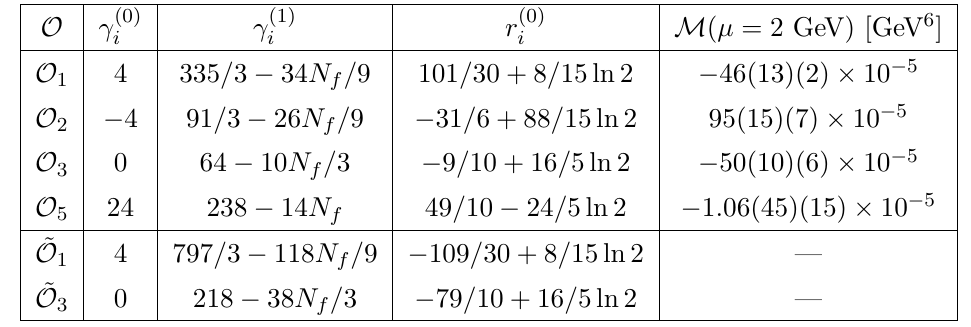
and γ (1) , and the one-loop matching factor i i